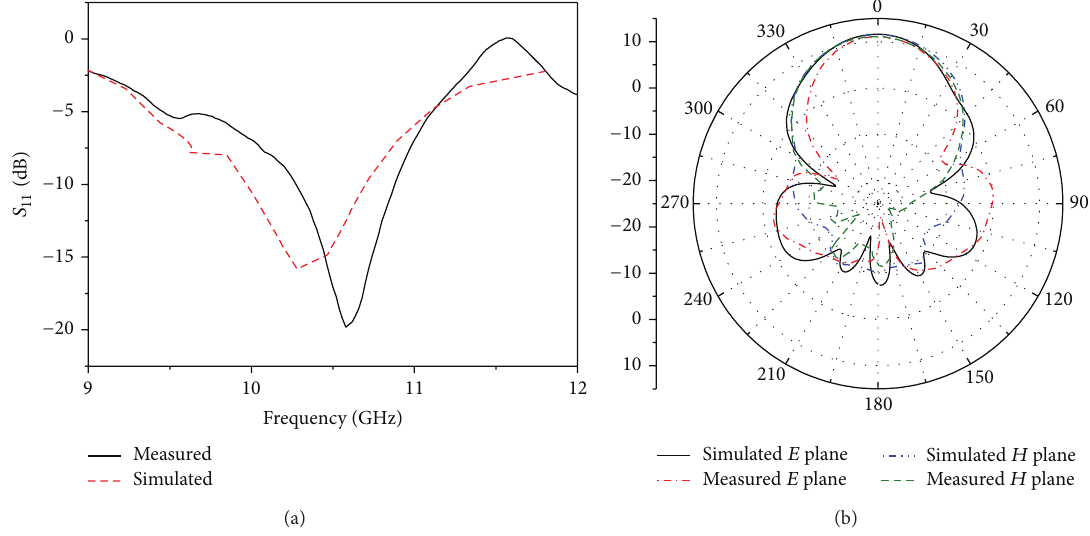
Figure 7: The performances of the proposed narrowband antenna with the ZIM cover, (a) the reflection coefficients and (b) the radiation patterns.